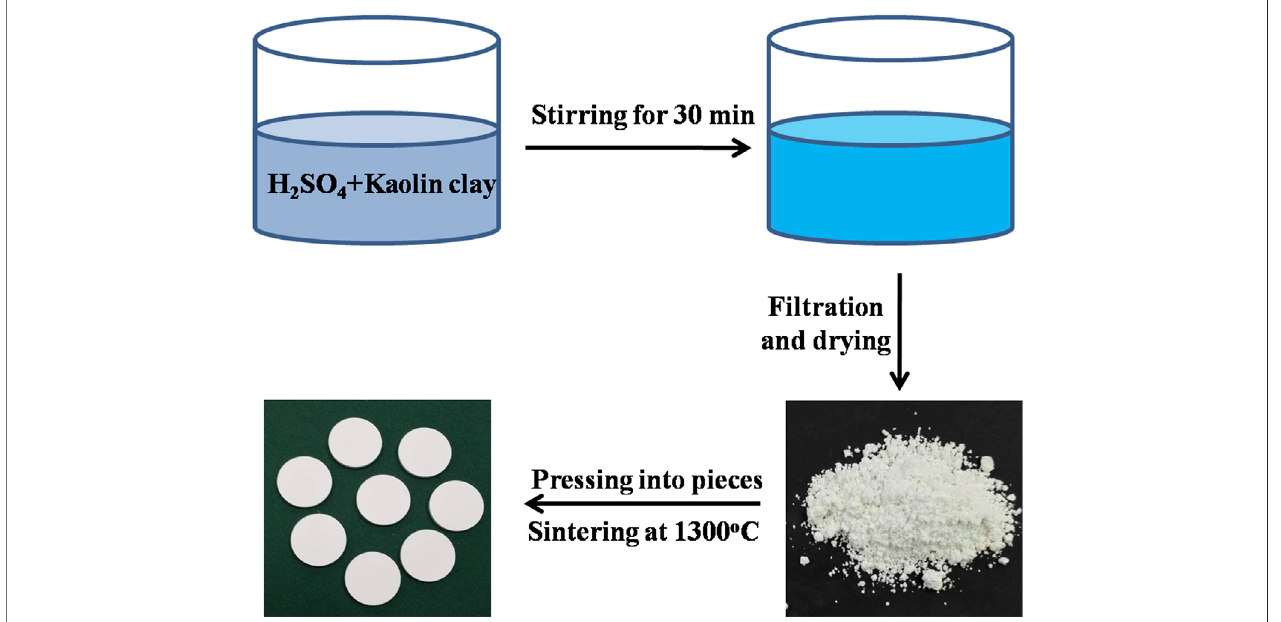
FIGURE 1 | The synthestic procedure and the synthesized kaolin clay ceramics.